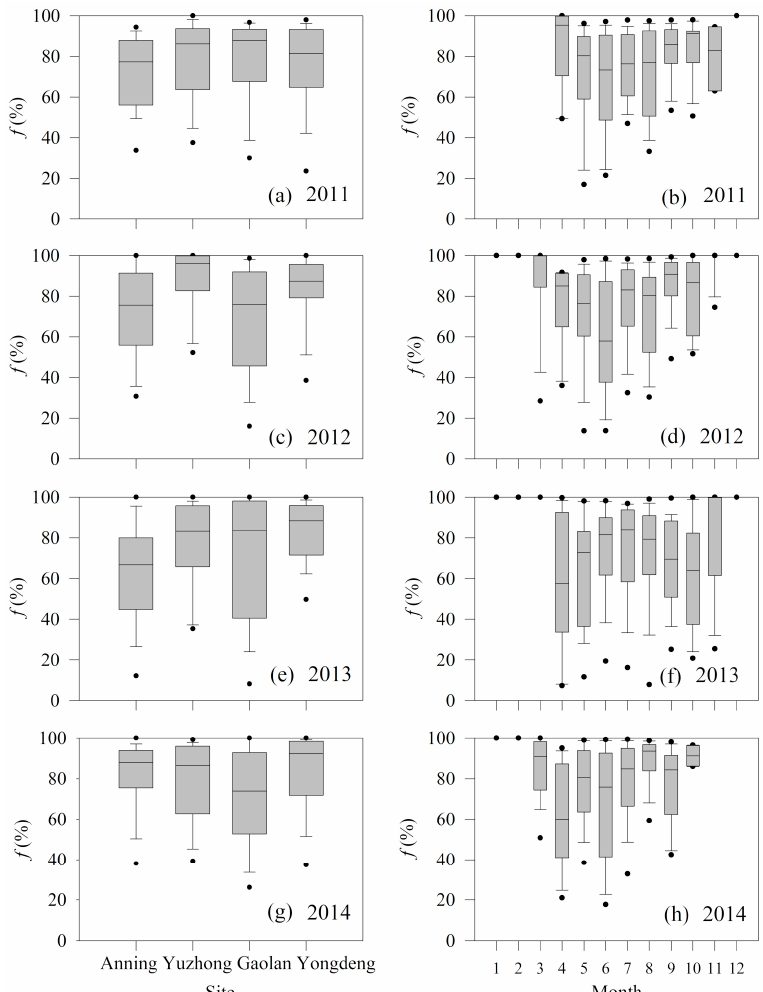
Figure 10. Regional ( a , c , e , g ) and monthly ( b , d , f , h ) variations of f in 2011 ( a , b ), 2012 ( c , d ), 2013 ( e , f ) and 2014 ( g , h ).